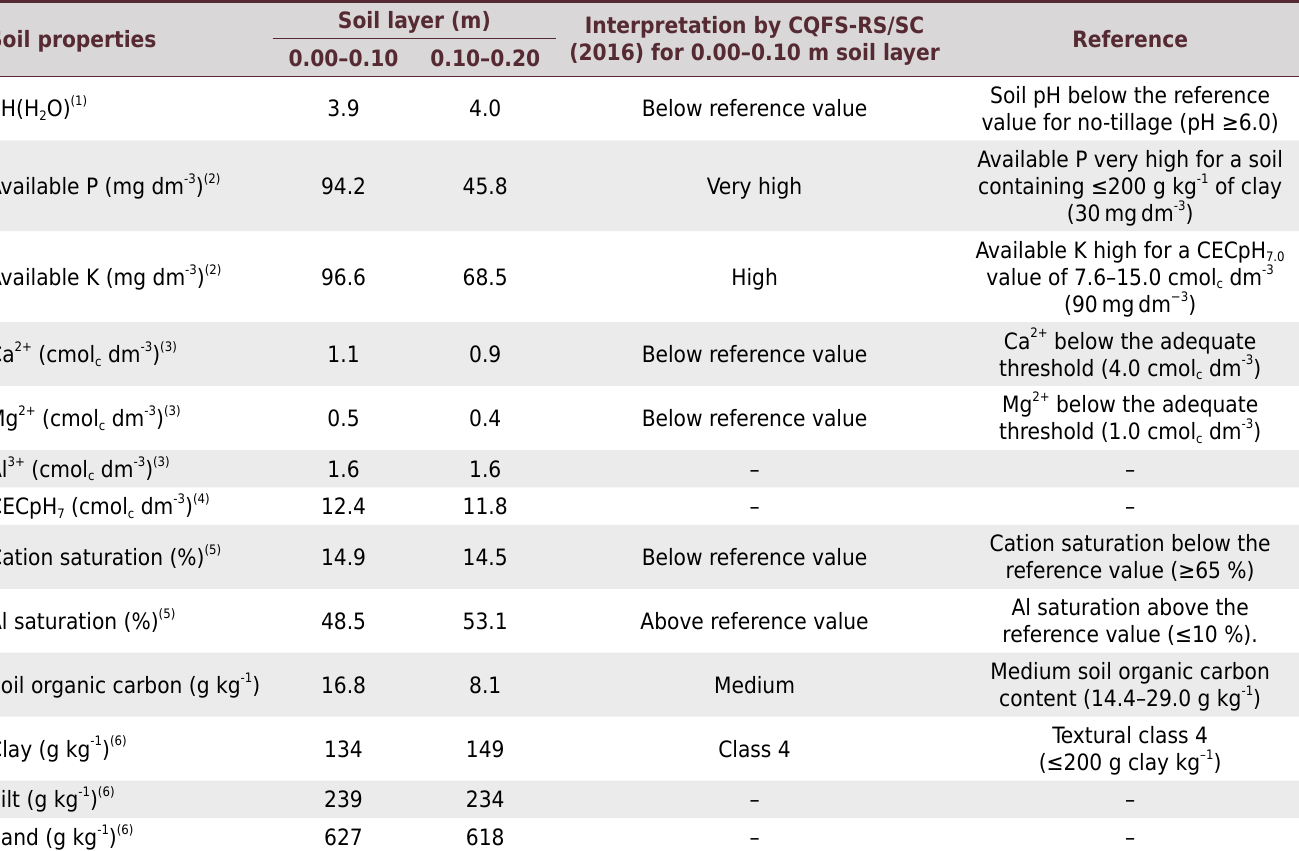
Table 1. Soil chemical and physical properties before the beginning of the field experiment (July 2017) in an Acrisol under no-tillage in Eldorado do Sul (Rio Grande do Sul State, southern Brazil) Soil